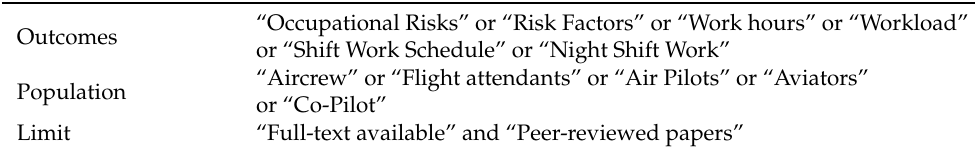
Table 2. Search terms on electronic